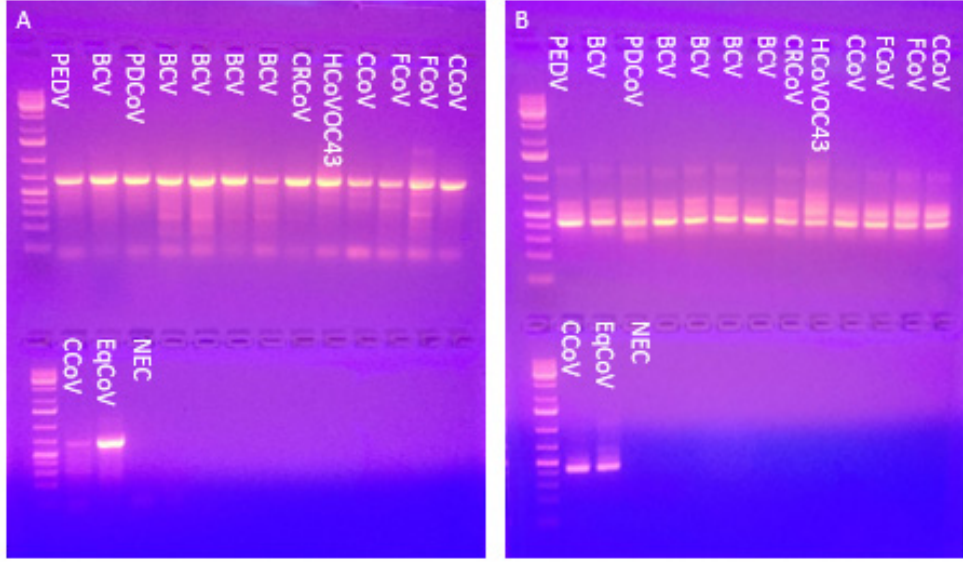
Figure 1. ( A ) Outer PCR for CoV references yielded a band ~600 bp. ( B ) Nested PCR for CoV references yielded a band ~430 bp. CoV references include porcine epidemic diarrhea virus (PEDV), five strains of bovine coronavirus (BCV), porcine deltacoronavirus (PDCoV), canine respiratory coronavirus (CRCoV), human coronavirus OC-43 (HuCoV-OC43), three strains of canine coronavirus (CCoV), two strains of feline coronavirus (FCoV), and equine coronavirus. NEC, negative extraction control.